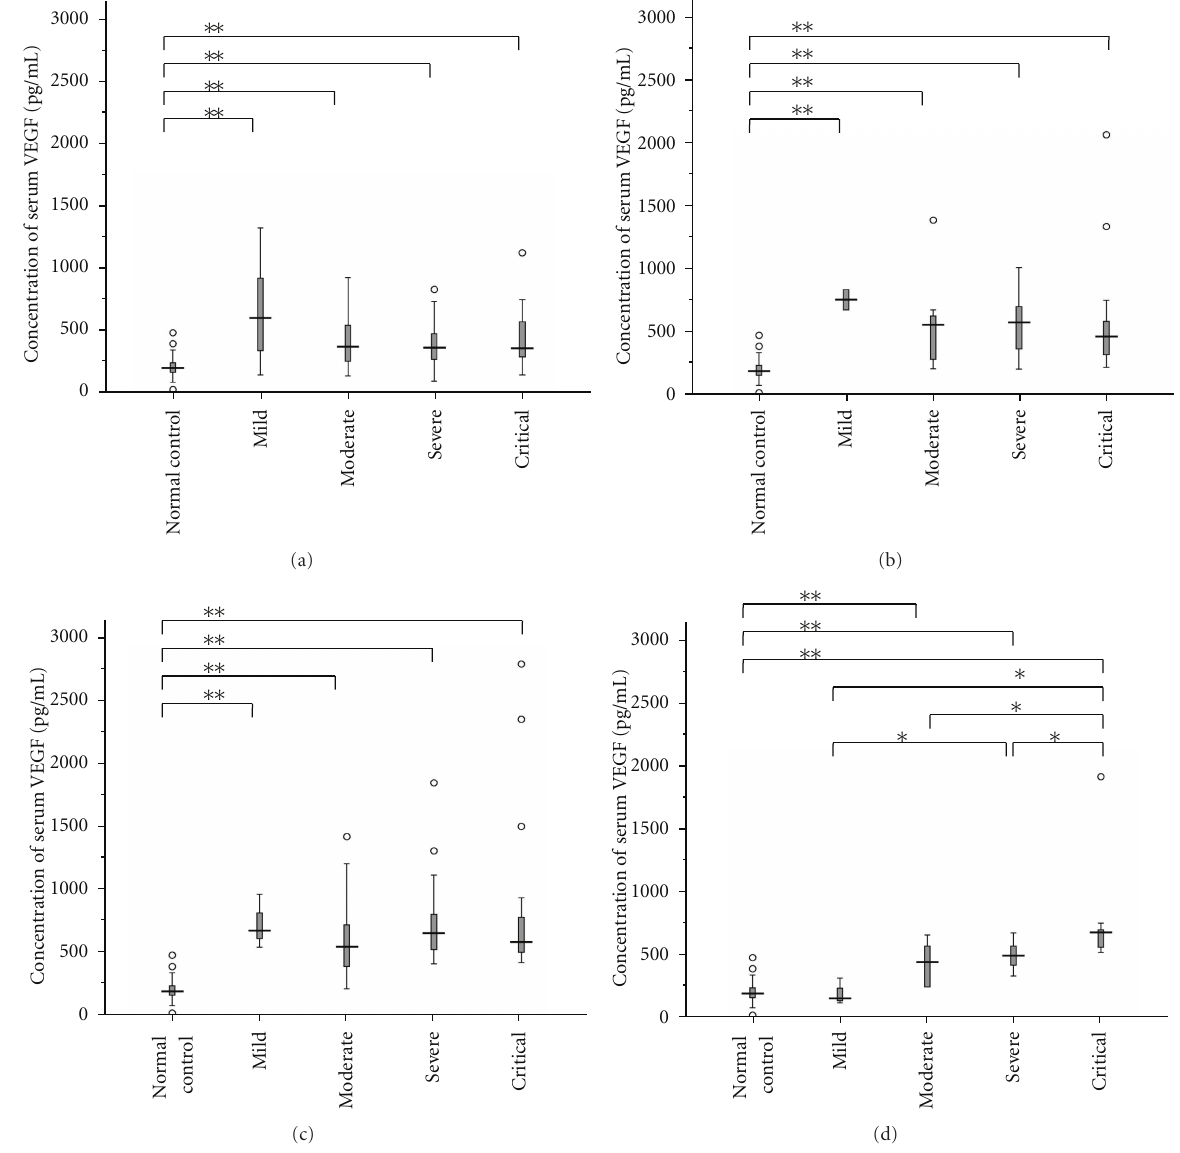
Figure 2: Compare the concentration of serum VEGF among four severity groups at each stage of HFRS. For (a) febrile/hypotensive stage, (b) oliguric stage, and (c) diuretic stage, the serum VEGF levels are significantly higher than those in healthy controls, but there was no di ff erence in the serum VEGF level among the four severity groups. (d) For the convalescence stage, the level of serum VEGF was higher in the more serious group. The significant di ff erence was performed among four groups. The Mann-Whitney U -test was used for a two-group comparison. ∗ P < 0 . 05, ∗∗ P < 0 .